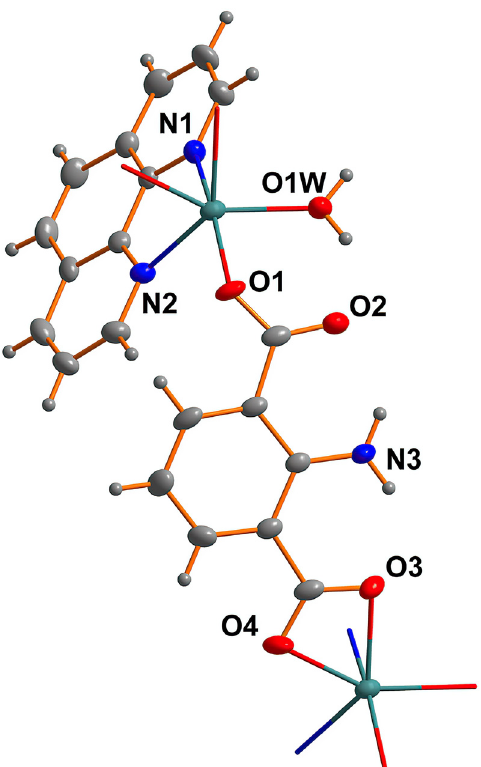
Table 1 contains crystallographic data and Table 2 contains the list of the atoms including atomic coordinates and displacement parameters.